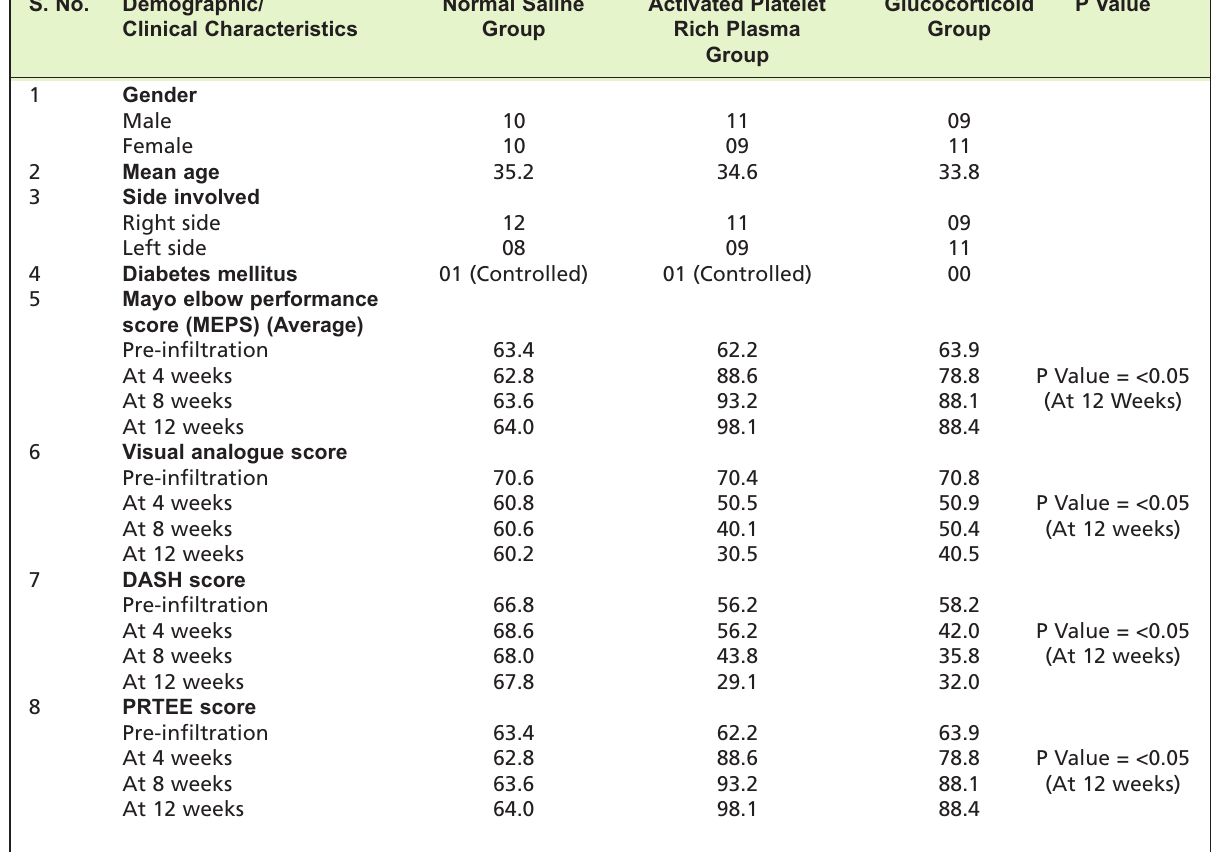
Comparative outcome of Management with Infiltrations of Leucocyte Enriched Platelet-Rich Plasma (LA- PRP), Table V: Glucocorticoid and Normal Saline S.